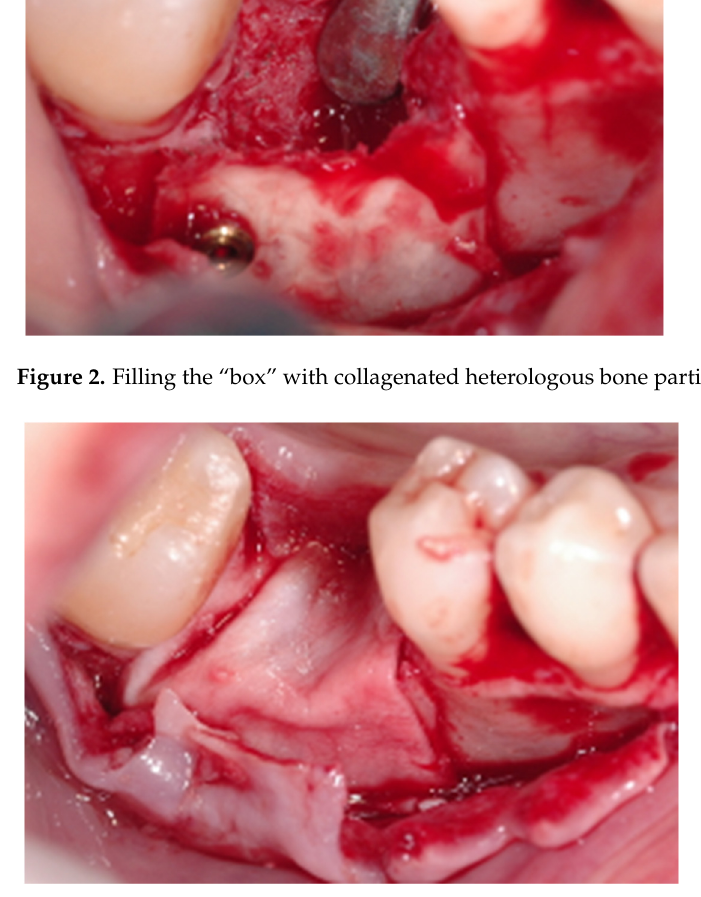
Figure 3. Placement of a collagen membrane to protect the graft.